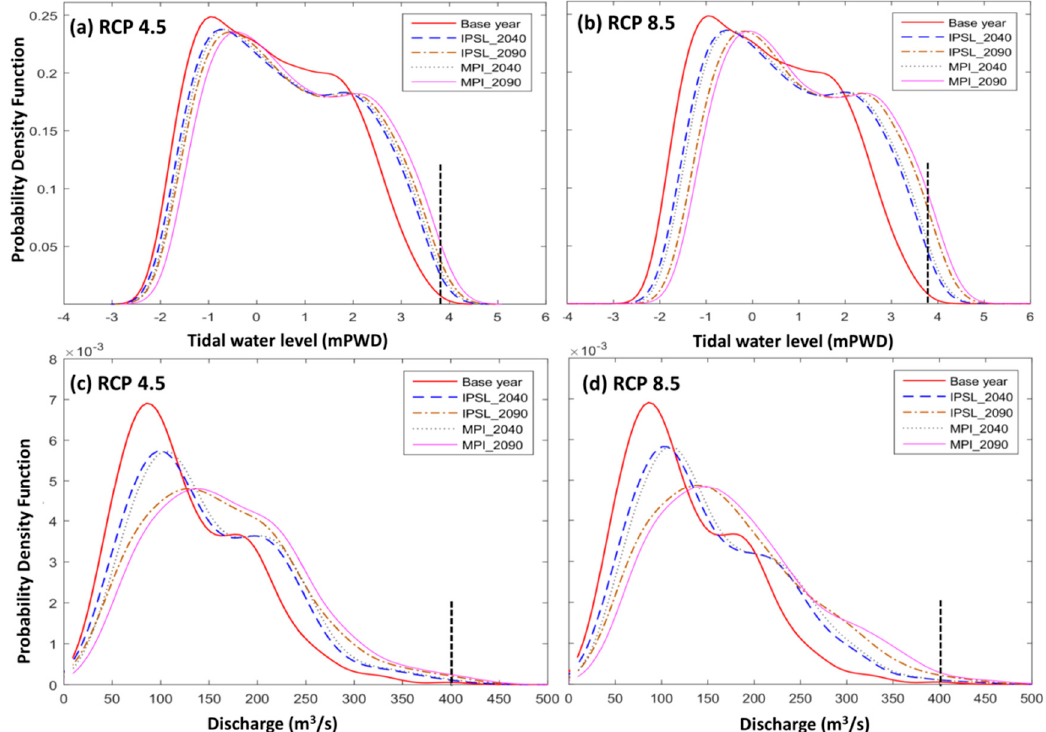
Figure 6. Probability density functions (PDFs) of hourly water levels ( a , b ) and daily maximum discharges ( c , d ) in the Betna River at Noapara for the baseline year (2014–2015) and in the near (2040s) and far (2090s) future under RCP 4.5 ( a , c ) and RCP 8.5 ( b , d ) for the two General Circulation Models (GCMs). The vertical dotted lines represent flood danger water levels ( a , b ) and extreme discharge levels ( c , d ).